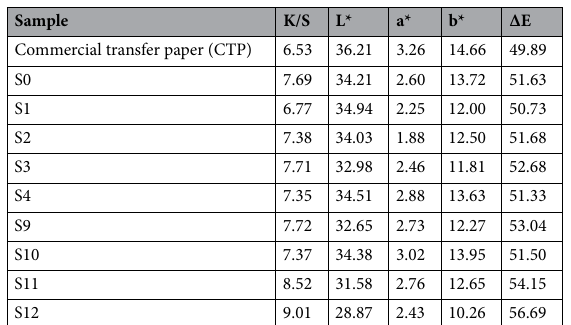
Table 3. The color strengths (K/S) and CIELAB color parameters of printed papers using silk screen technique.